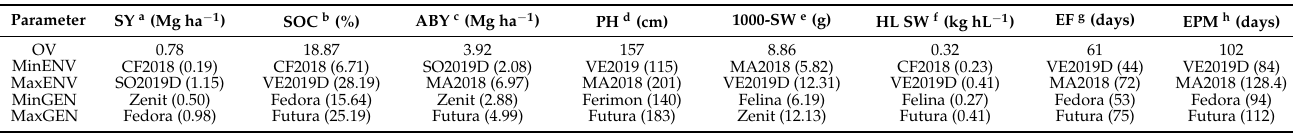
a Seed yield; b seed oil content; c aboveground biomass yield; d plant height; e seed weight; f hectolitre seed weight; g duration from emergence to flowering period; h duration from emergence to physiological maturity